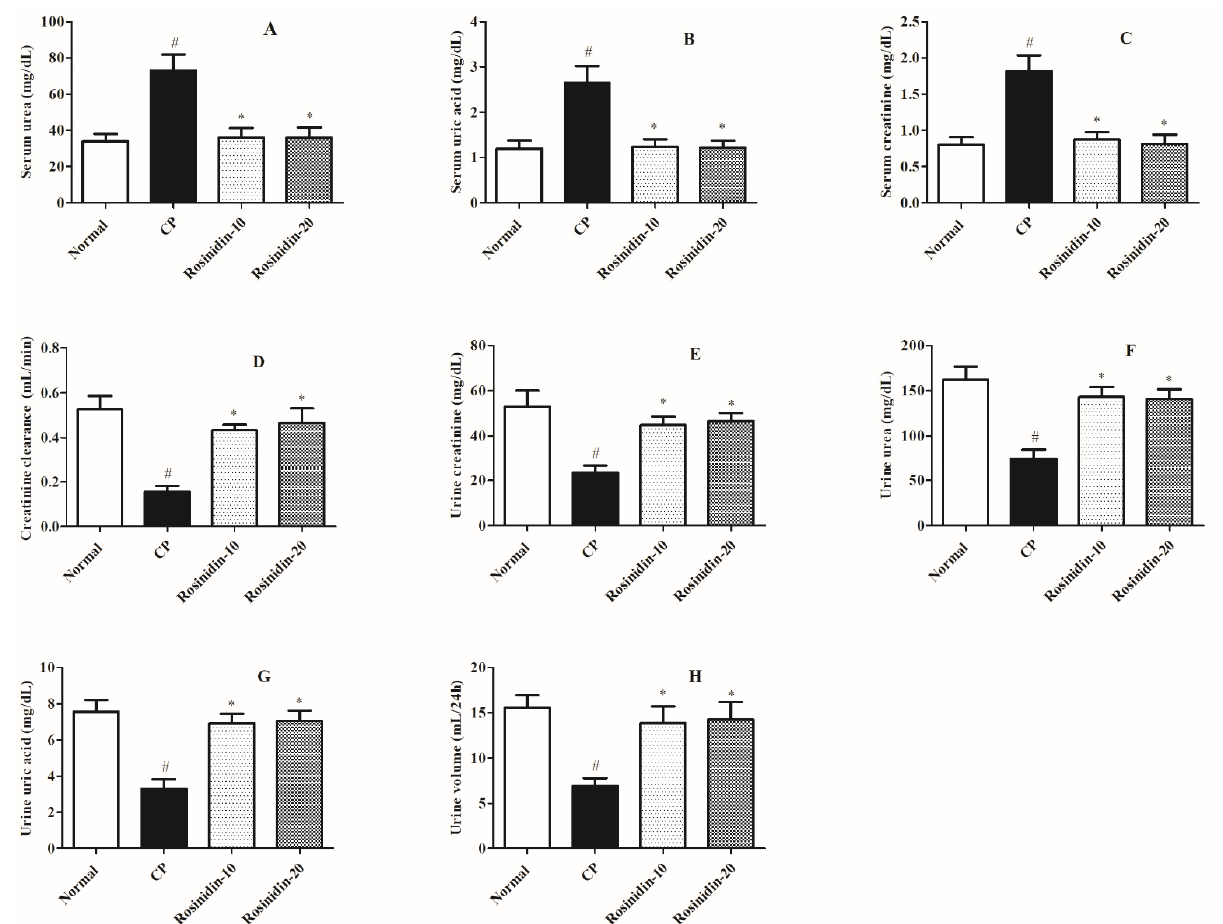
Figure 1. Effect of rosinidin on the estimation of non-protein-nitrogenous components against cisplatin-induced nephrotoxicity in rats. ( A ) Serum Urea ( B ) Serum Uric Acid ( C ) Serum Creatinine ( D ) Creatinine Clearance ( E ) Urine Creatinine ( F ) Urine Urea ( G ) Urine Uric Acid ( H ) Urine Volume. Data were presented as mean ± SEM ( n = 6). # Indicate significant alteration for normal vs. control, * indicated modulations observed in rosinidin vs. cisplatin. p value less than 0.05 were considered statistically significant. The analysis was carried out by employing Kruskal–Wallis test.